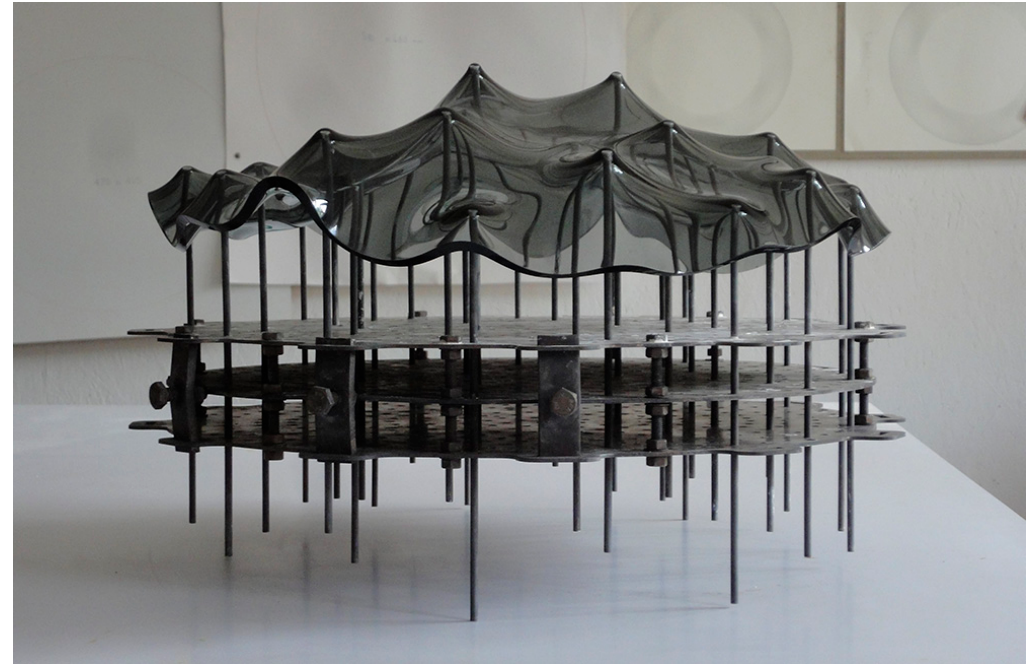
Figure 9. RPT system with a bowl formed upside down on the pins, (photo: Jorgensen, T. 2013).